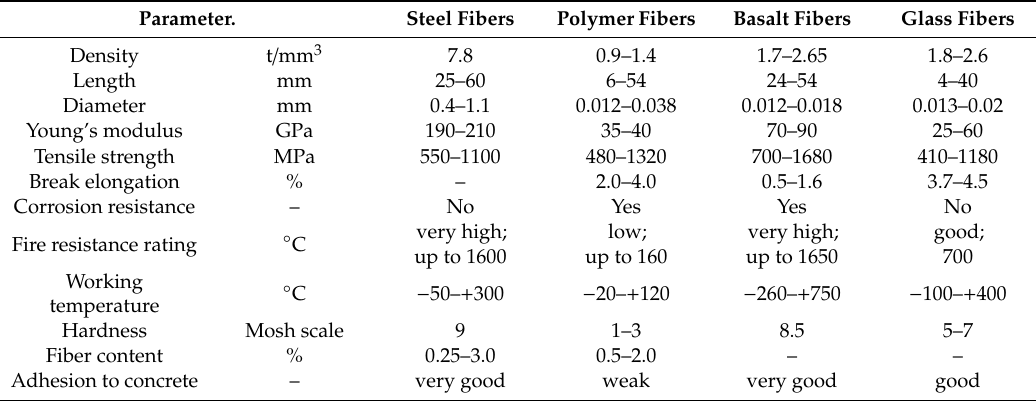
Table 1. Parameters of various fibers used for concrete reinforcement